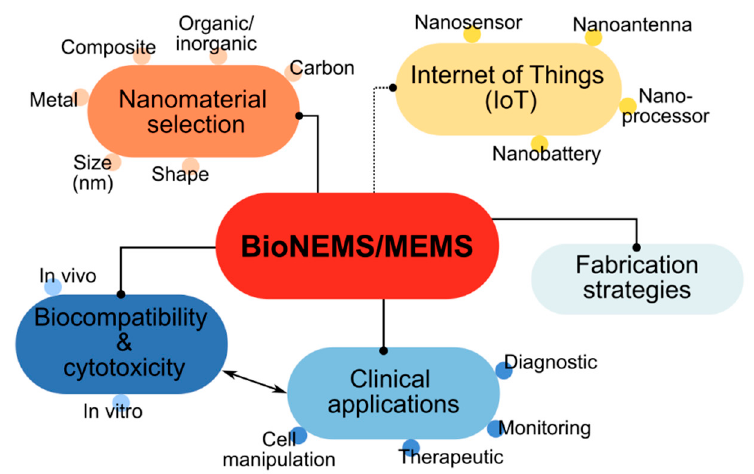
Figure 1. Development trends and clinical applications of nanomaterials-based bioNEMS/MEMS devices and future opportunities for integration with Internet of Things (IoT) technology.